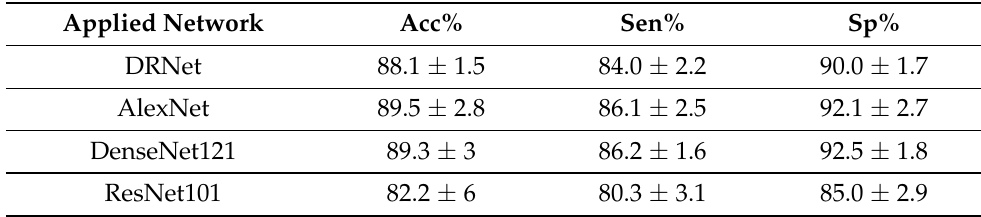
Table 3. Ten-fold comparisons for images composed of gray level and the reflectivity map only. Applied Network